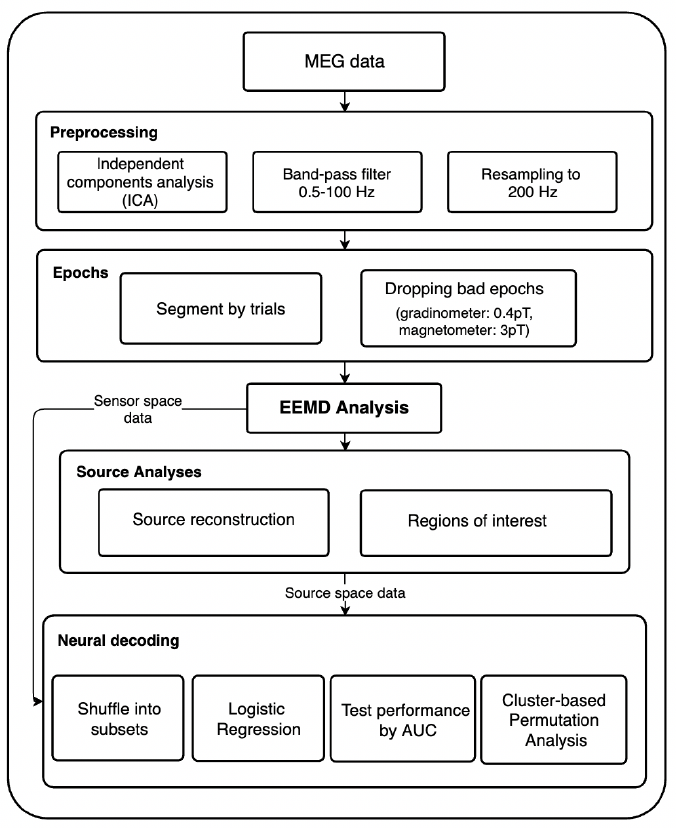
Figure 1. This figure shows the step-by-step data processing procedures along with all the analyses that we